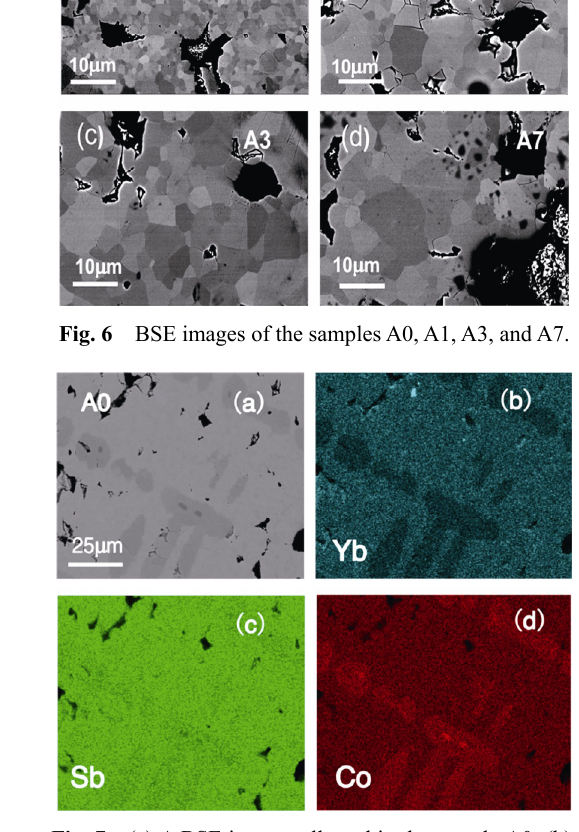
Fig. 7 (a) A BSE image collected in the sample A0; (b), (c), and (d) EDS mappings of Yb, Sb, and Co elements,